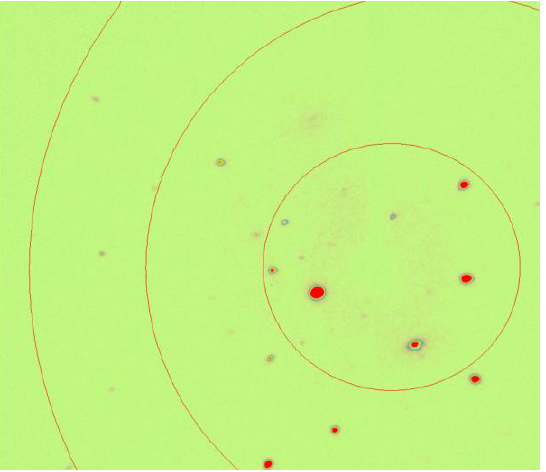
Figure 7. Diffraction image segmentation in HSV space to illustrate the brightness, saturation and chroma of pixels.